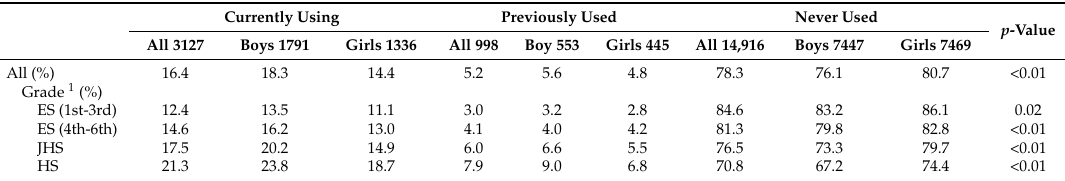
Table 2. The prevalence of dietary supplement use in children in the preliminary